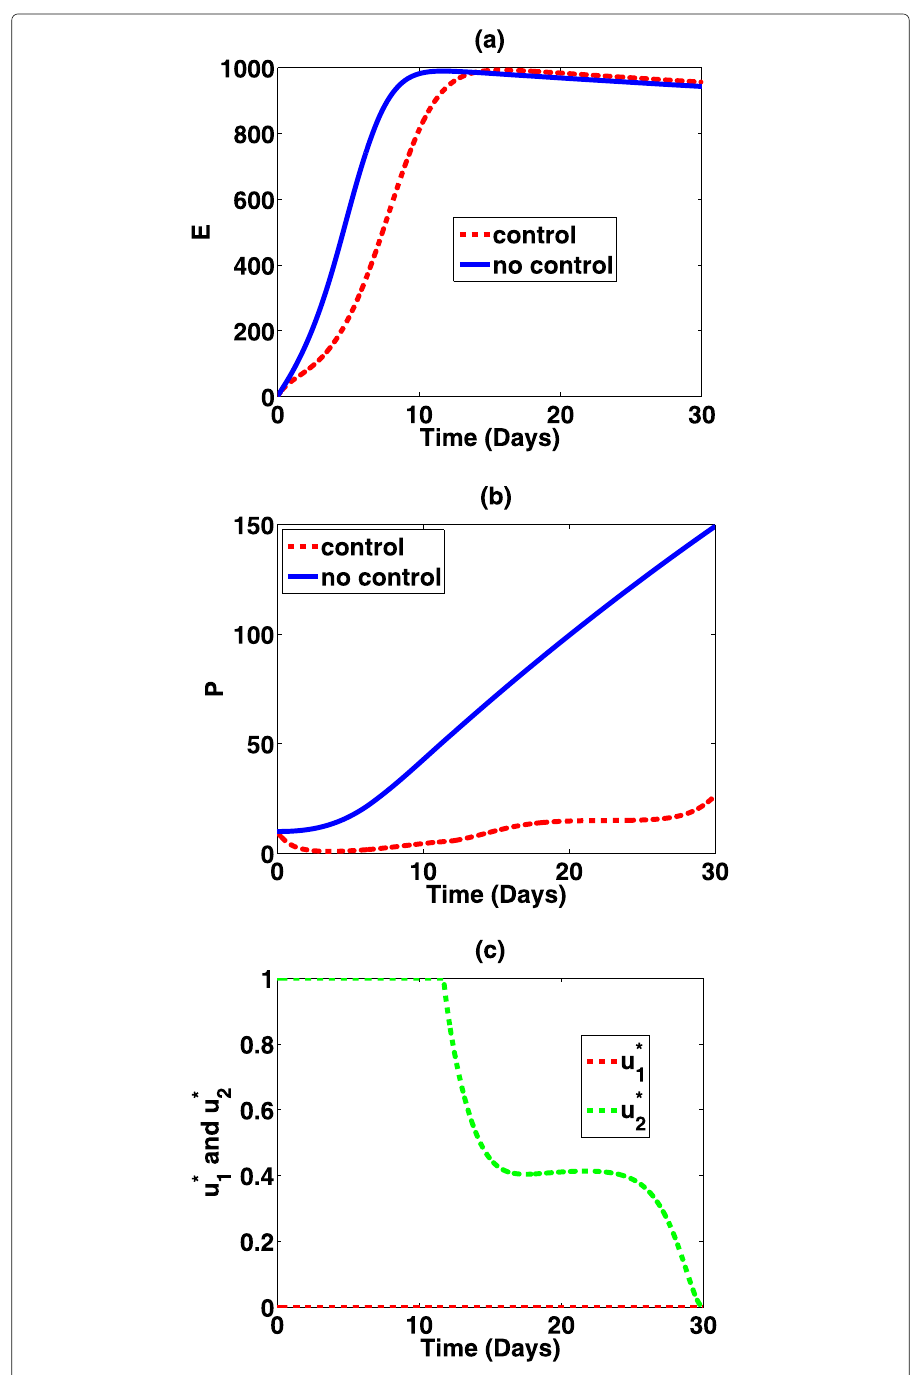
Fig. 3 a – c Optimal states and control profile for control strategy B